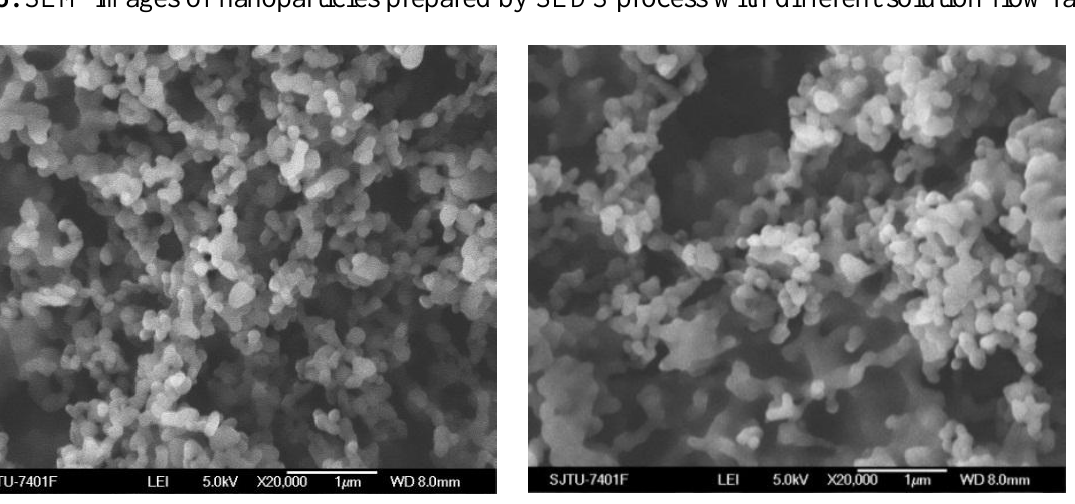
Figure 5. SEM images of nanoparticles prepared by SEDS process with different solution flow rates.